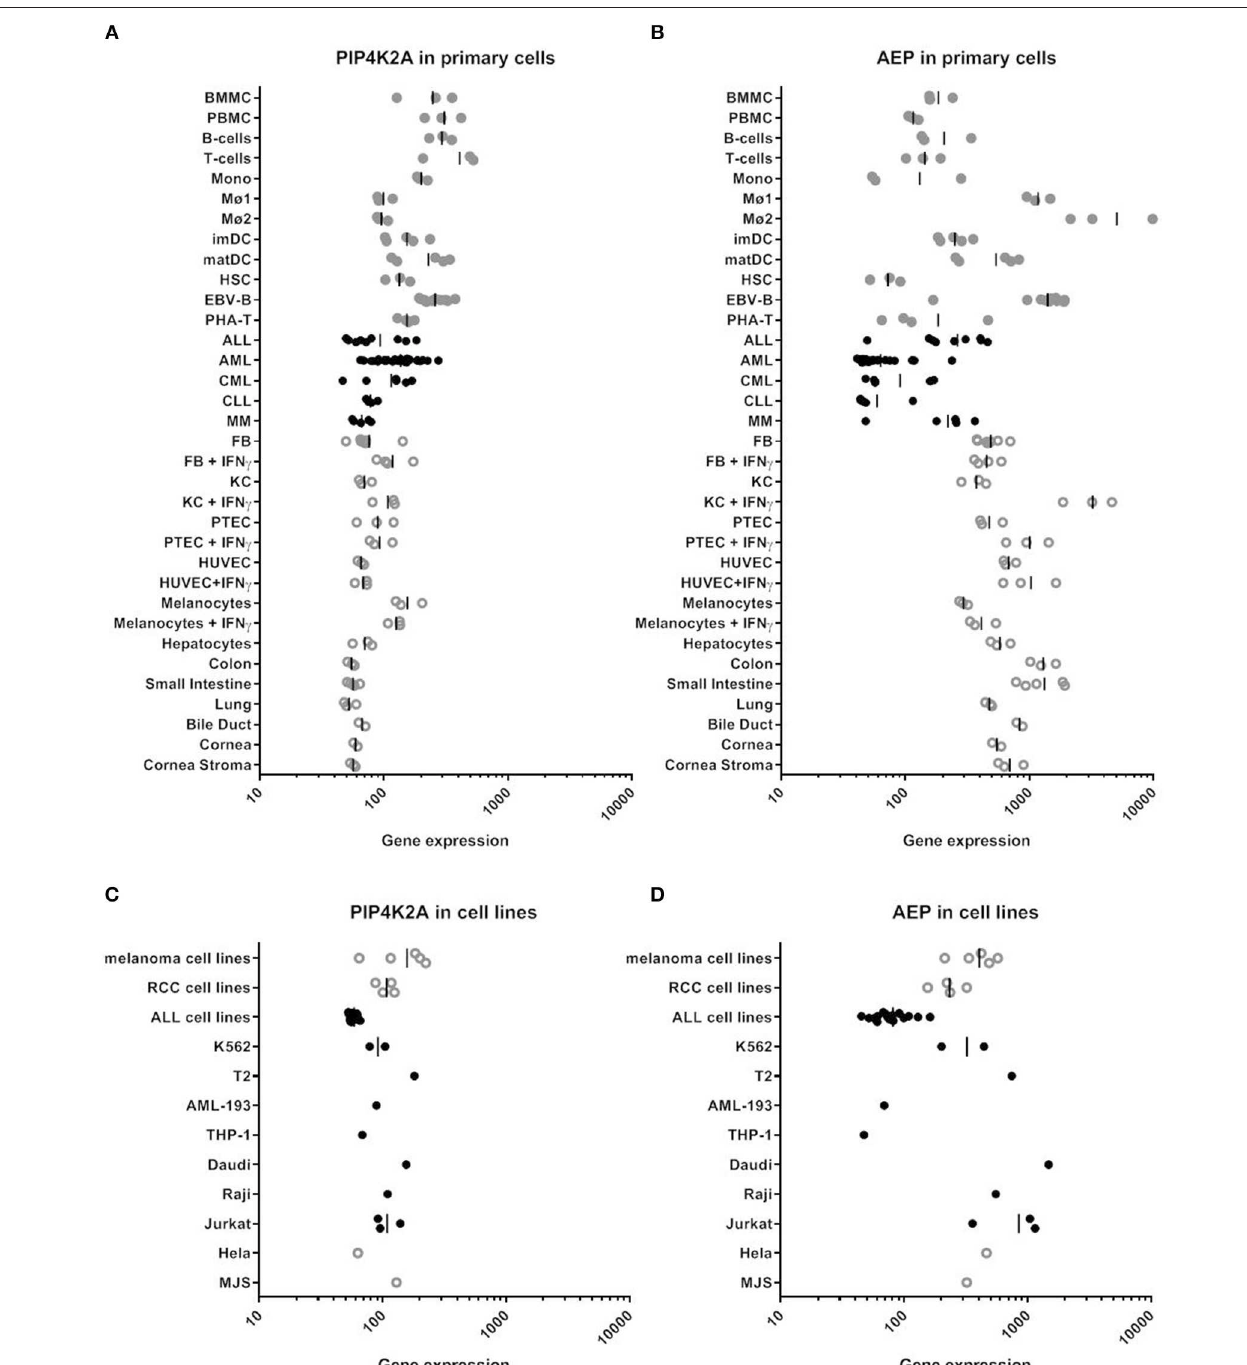
FIGURE 4 | RNA expression of PIP4K2A and AEP in various human cell types by microarray gene analysis. (A) PIP4K2A gene expression in primary cells. (B) AEP gene expression in primary cells. (C) PIP4K2A gene expression in cell lines. (D) AEP gene expression in cell lines. Healthy and malignant hematopoietic cells are represented by gray and black dots, respectively, while open symbols represent non-hematopoietic cell types. Gene expression was measured on Illumina HT-12 BeadChips as described previously (30). BMMC, bone marrow mononuclear cells; PBMC, peripheral blood mononuclear cells; Mono, monocytes, Mø1, type 1 macrophages; Mø2, type 2 macrophages; imDC, immature dendritic cells; matDC, mature dendritic cells; HSC, hematopoietic CD34 + stem cells; EBV-B, EBV-transformed B cells; PHA-T, PHA-stimulated T-cells; ALL, acute lymphocytic leukemia; AML, acute myeloid leukemia; CML, chronic myeloid leukemia; MM, multiple myeloma; FB, fibroblasts; KC, keratinocytes; PTEC, proximal tubular epithelial cells; HUVEC, human umbilical vein endothelial cells.